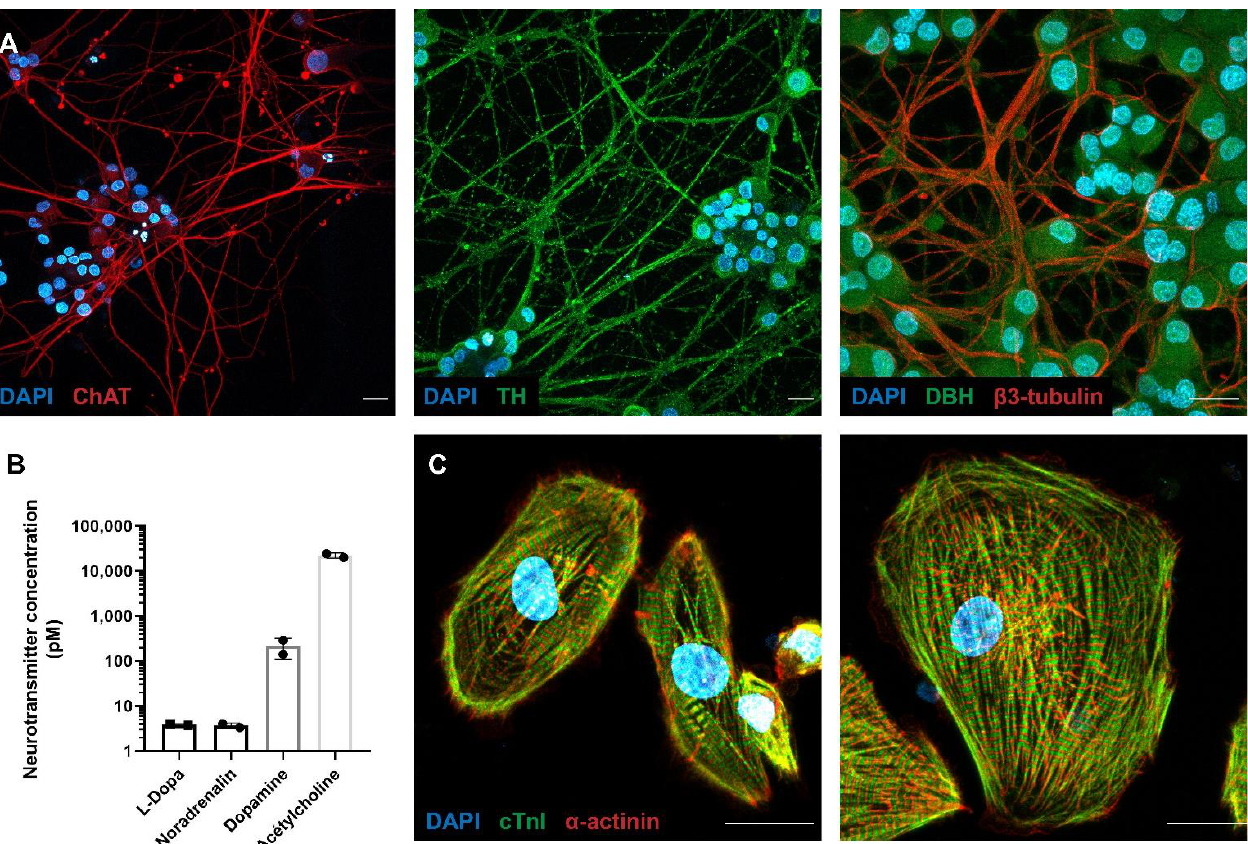
Figure 1. Molecular characterization of neuro–cardiac OOC composed of PC12 cells and hiPSC-CMs. ( A ) PC12 cells differentiate into parasympathetic neurons. PC12 were cultured for 14 days in the presence of 50 ng/mL NGF, fixed and immunolabelled for sympathetic markers. Representative immunofluorescence microscopy images show choline acetyltransferase ( left panel ; in red), tyro- sine hydroxylase ( central panel ; in green), dopamine β -hydroxylase ( right panel ; in green), and β3 - tubulin ( right panel ; in red). ( B ) Quantification of neurotransmitters in supernatant of PC12 cells. PC12 cells were differentiated for 14 days and subjected to addition of 1.5 mM Carbachol for 2 min. Then, medium was collected and the indicated neurotransmitters were quantified as described in the Materials and Methods section. ( C ) hiPSCs differentiate in cardiomyocytes (hiPSC-CMs) after 30 days following the so- called “matrix sandwich method” of differentiation. hiPSC -CMs were fixed and immunolabelled for sarcomeric cardiac markers. Representative immunofluorescence micros- copy images show Cardiac troponin (in green) and the α -sarcomeric actinin (in red). Scale bars: 20 µm.